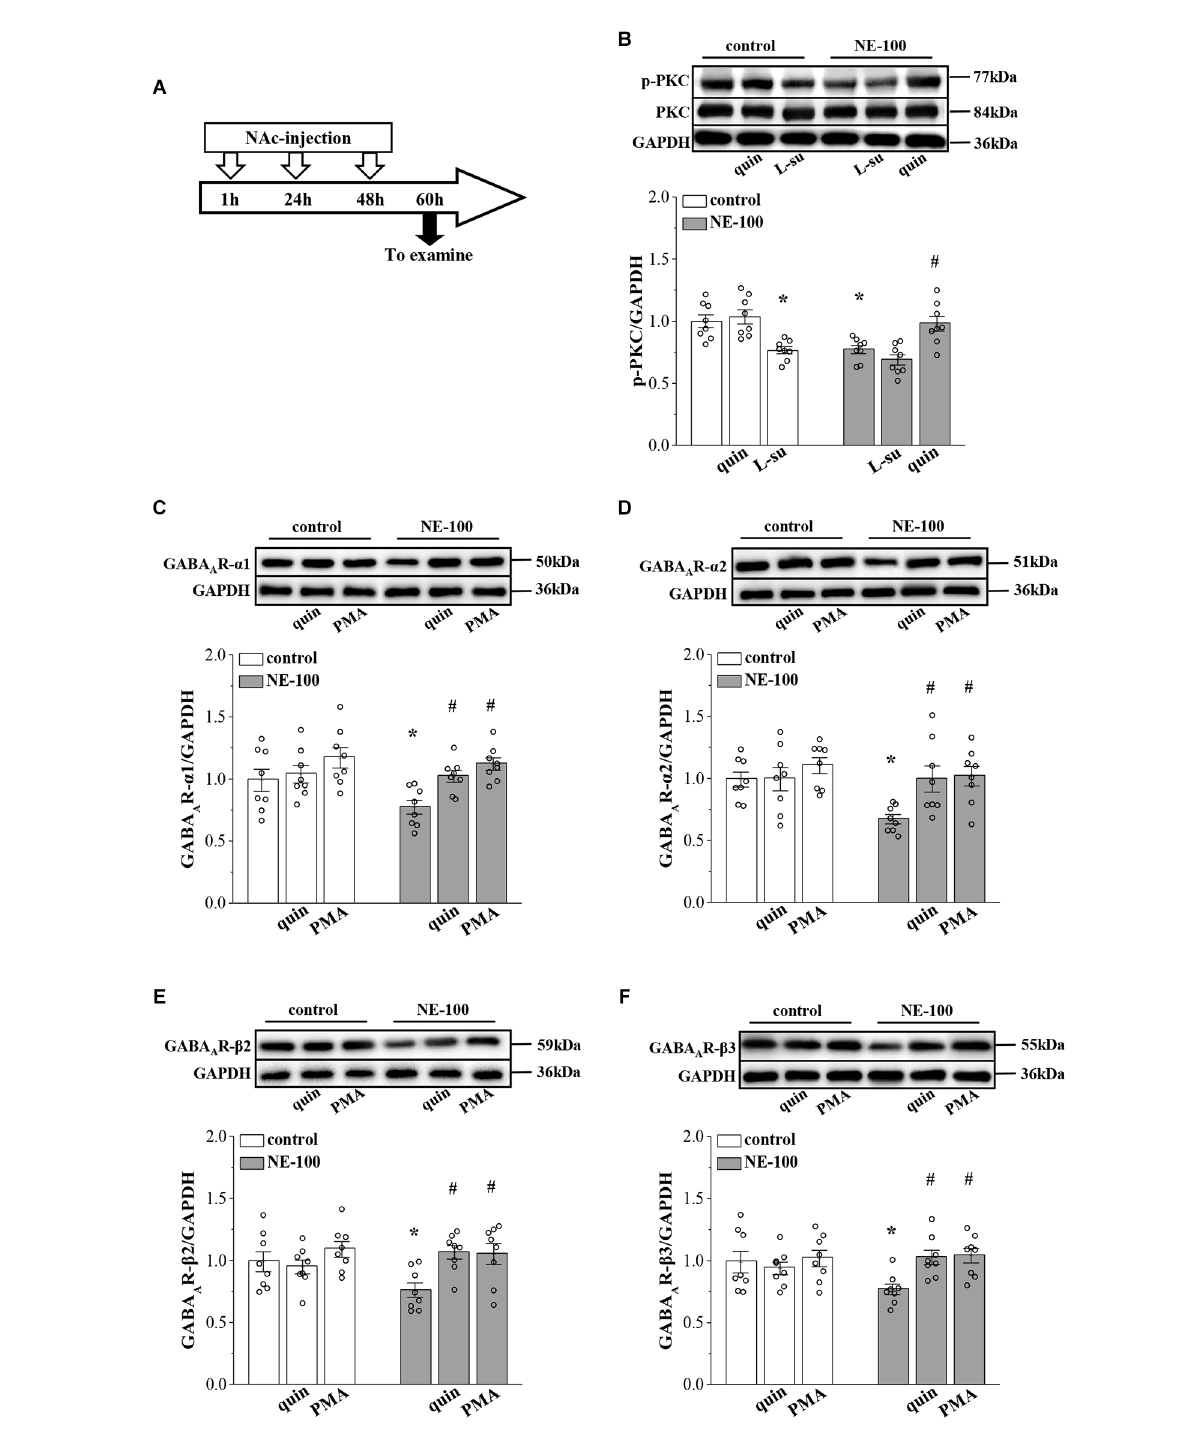
FIGURE4 Repeated injection of NE-100 reduces PKC signaling leading to decreased GABA A R expression. (A ) Time chart of the experimental procedure. (B ) Representative blots of phospho-PKC in the NAc of control mice treated with quinpirole (quin) or L-sulpiride (L-su), and NE-100 mice treated with L-sulpiride (L-su) or quinpirole (quin). Densitometric values of phospho-PKC normalized by the PKC protein were normalized by control levels. * p < 0.05 vs. control mice; # p < 0.05 vs. NE-100 mice ( n = 8 mice per group; two-way ANOVA). (C – F ) Bar graphs show levels of GABA A R- α 1, GABA A R- α 2, GABA A R- β 2, and GABA A R- β 3 protein in the NAc of control mice and NE-100 mice treated with NAc-injection of quinpirole (quin) or PMA. Densitometric values normalized by the level of GAPDH were normalized by control levels. * p < 0.05 vs. control mice; # p < 0.05 vs. vehicle-treated NE-100 mice ( n = 8 mice per group; two-way